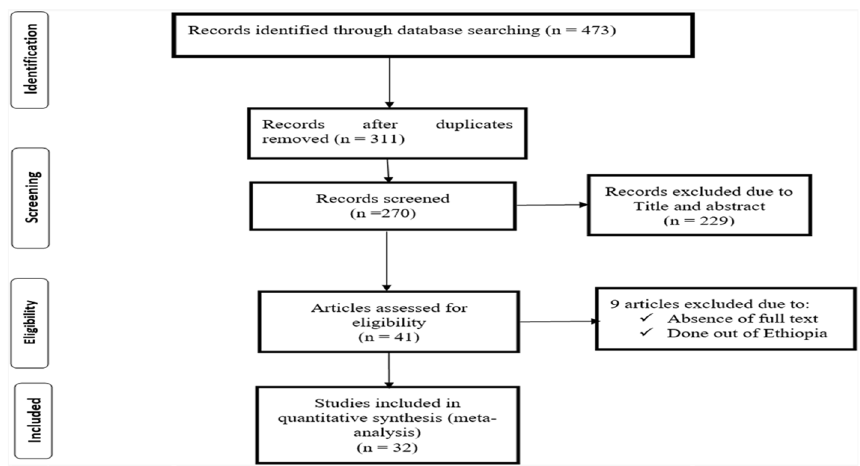
Figure 1. PRISMA flow diagram describing the selection of studies for systematic review and